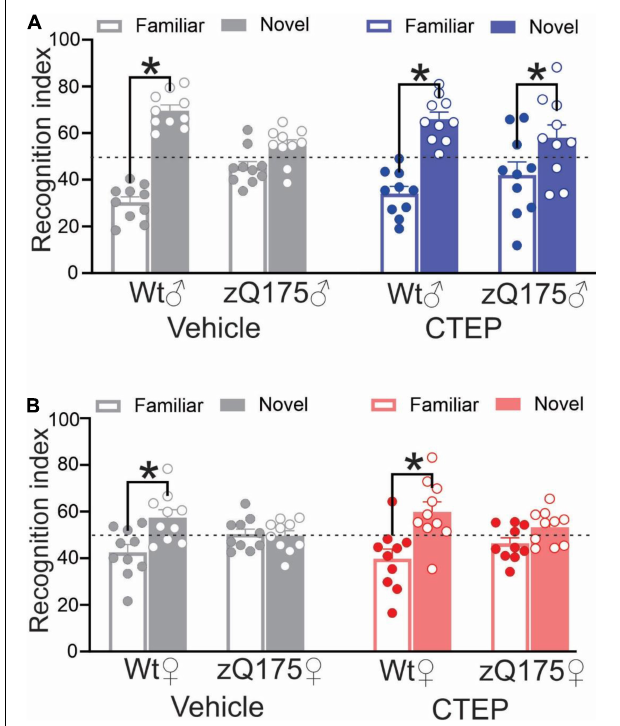
FIGURE 3 | Effect of chronic administration of CTEP on novel object recognition in male and female zQ175 mice. Mean ± SEM of the recognition index, for exploring a novel object versus a familiar object on the second day of novel object recognition test, after 12 weeks of treatment with either vehicle or CTEP (2 mg/kg/48 h) of 12-month-old heterozygous zQ175 (zQ175) and wild-type (Wt) male (A) and female (B) mice ( n = 10 for all groups). * P < 0.05 by two-way analysis of variance (ANOVA) and Tukey’s multiple comparisons